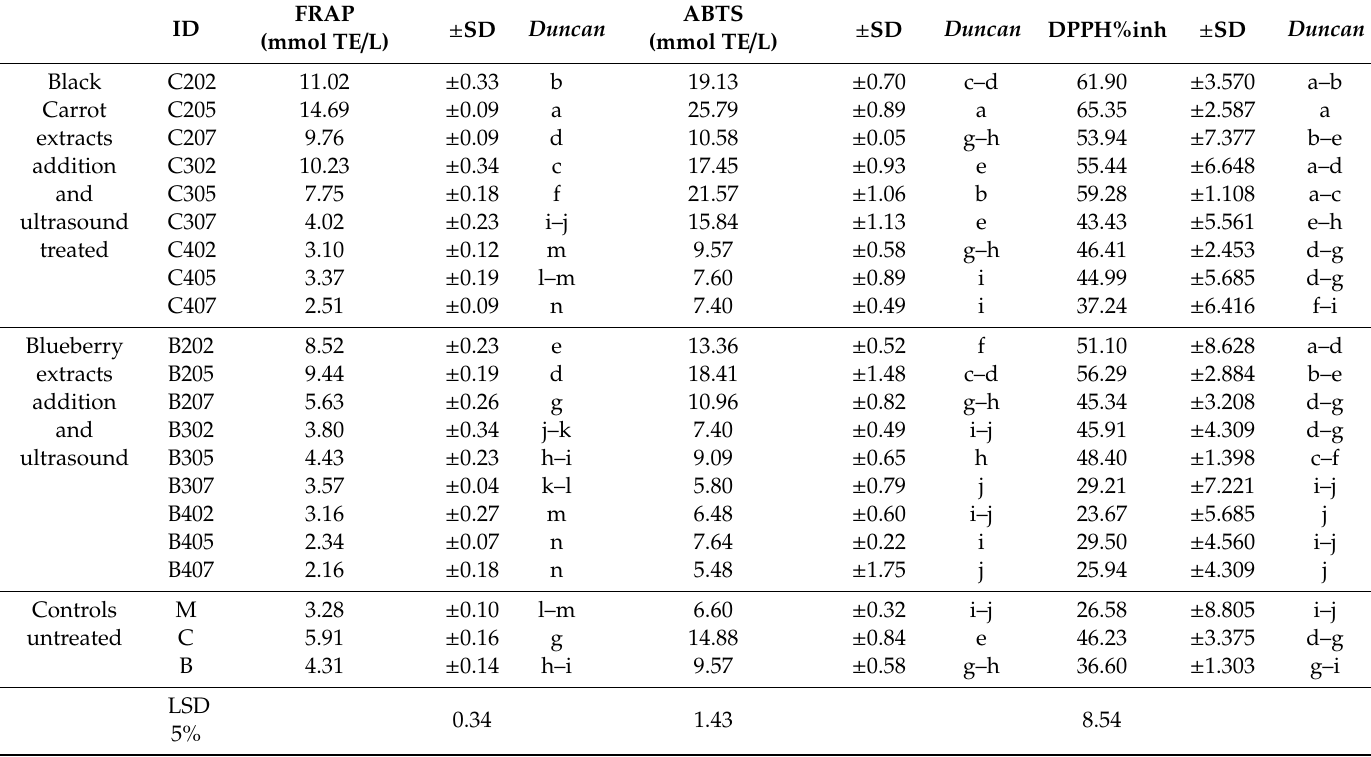
Table 7. Antioxidant capacity of the cider experimental variants enriched with antioxidants extracts and